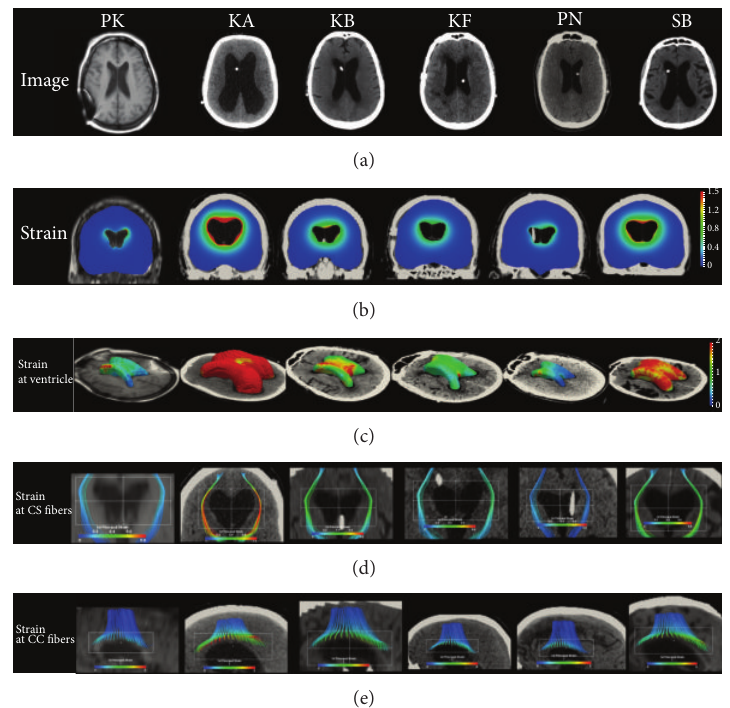
Figure 3: Overview of the 6 patients at their postoperative stages. Each row from top to bottom represents the medical images used for nonlinear image registration from which the strain level was quantified in the entire brain, and the calculated strain levels are illustrated at coronal sections and the ventricular walls. At bottom the strain level at CS and CC fiber tracts is presented.